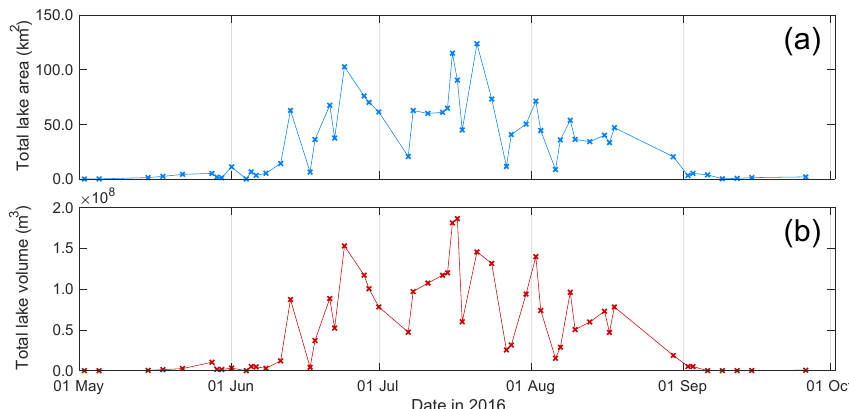
Figure 7. Estimates of evolution to total lake (a) area and (b) volume across the whole study region during the 2016 melt season after daily values were normalised against the proportion of the region visible on that day (i.e. not obscured by cloud or missing data). Values are derived by dividing the daily total lake area and volume by the portion of the region visible on that day (see Fig. 6).